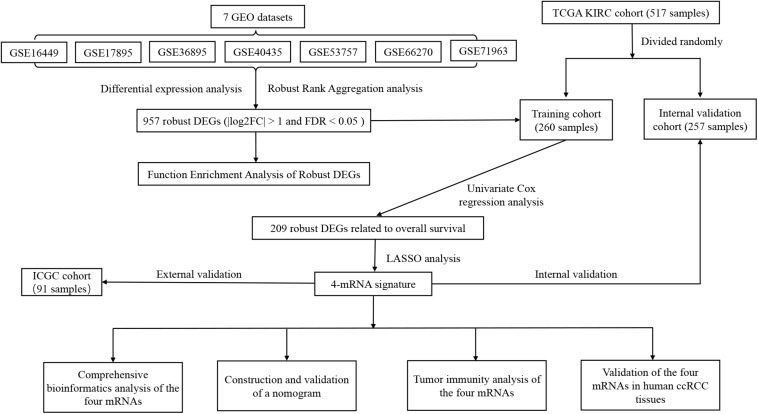
Flowchart showing the process of developing the mRNA signature and the nomogram of ccRCC in this study.